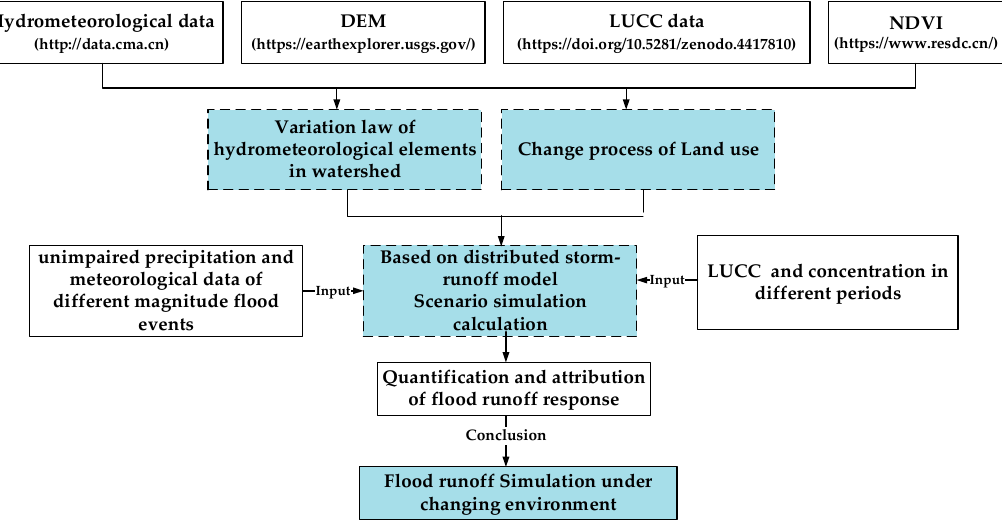
Figure 2. The technological route and research method employed in the current